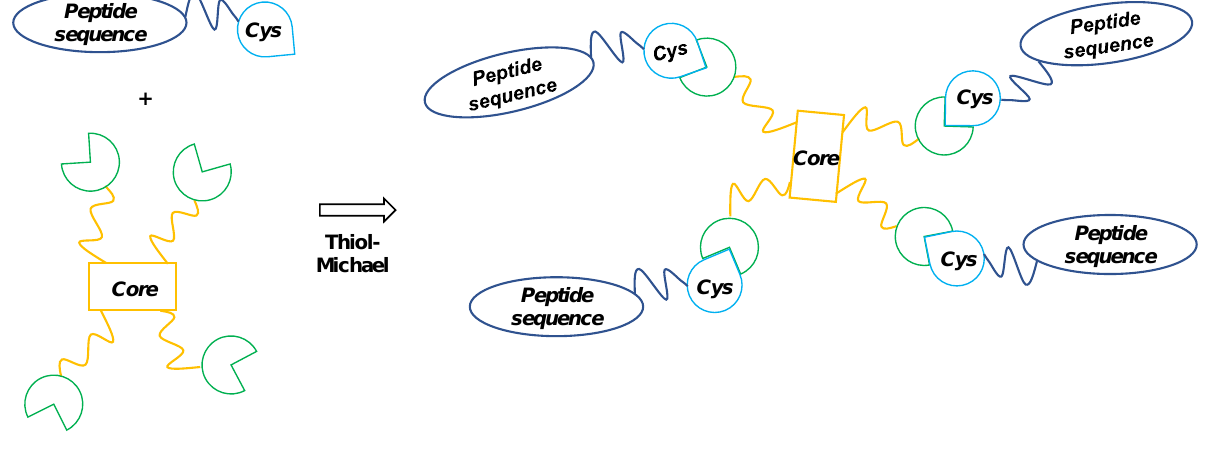
Figure 5. Representation of the convergent chemical